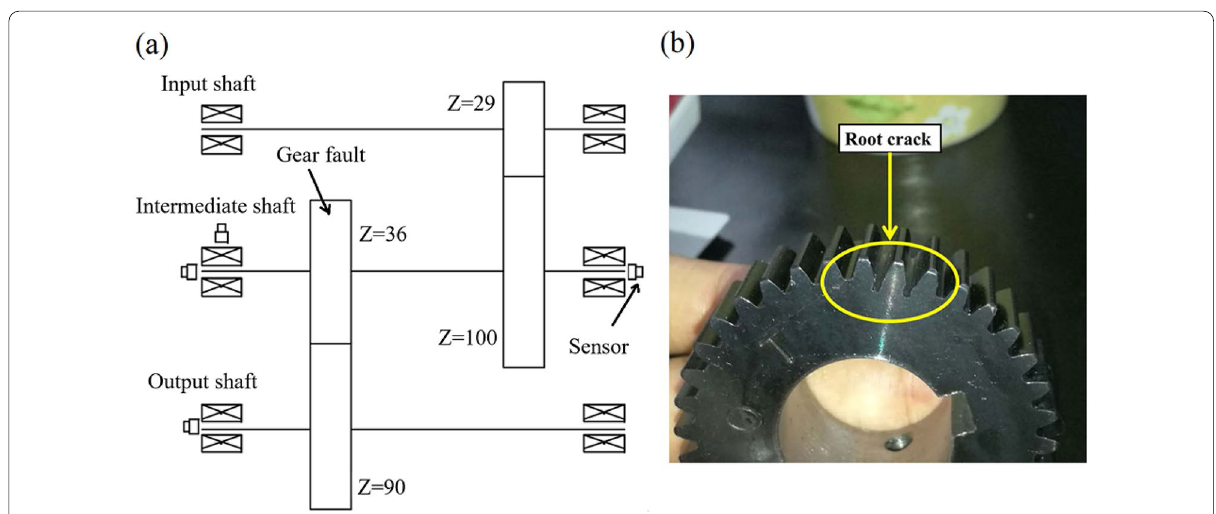
Figure 25 ( a ) Inner structure of gearbox and ( b ) root crack